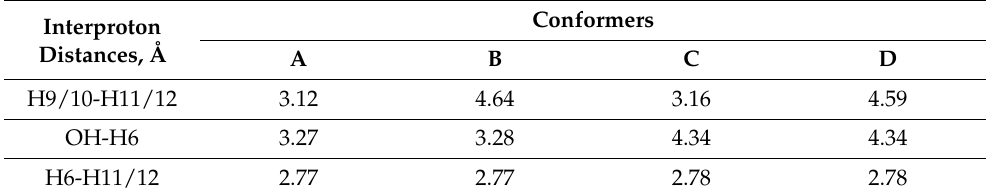
Table 1. Conformation-dependent distances in the MFA conformers based on quantum-chemical calculations. Conformers Interproton Distances, Å A H9/10-H11/12